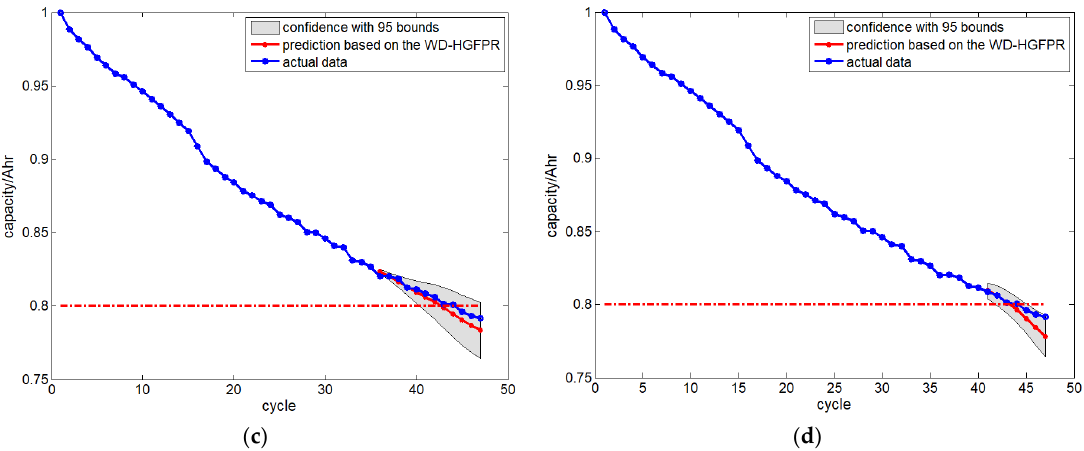
Figure 8. Prediction results using proposed method with different lengths of training data for Cell-4 battery. ( a ) RUL prediction results with 20 training data, ( b ) RUL prediction results with 30 training data, ( c ) RUL prediction results with 35 training data, and ( d ) RUL prediction results with 40 training data.